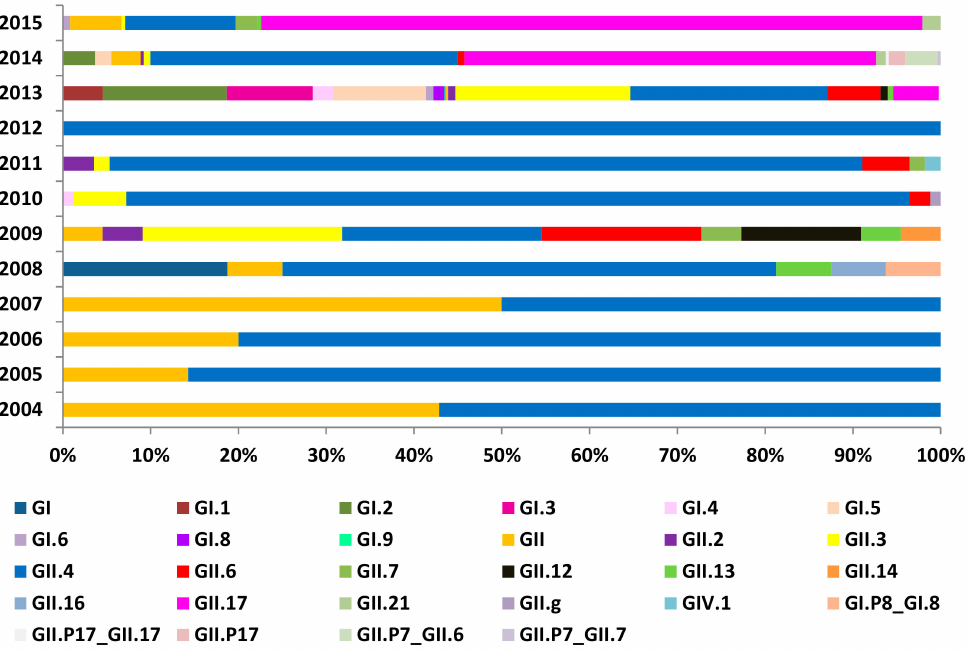
Figure 5. Percentage of total norovirus genotypes during 2004 to 2015. The bar in the figure was generated by the number of genotypes ( n =